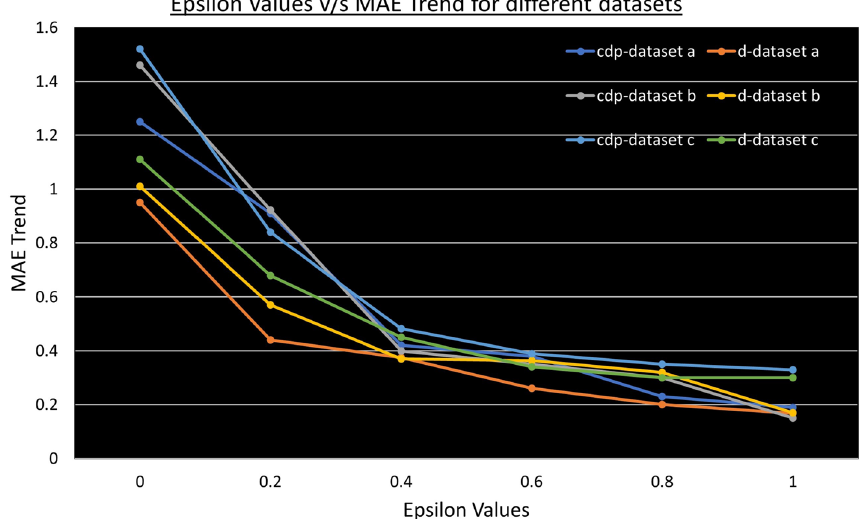
Fig. 11 Epsilon versus MAE Trend for the different